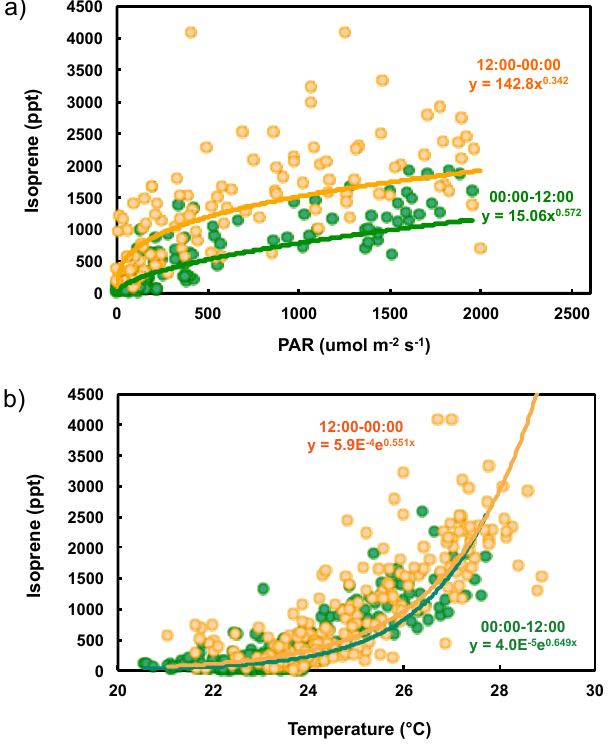
Fig. 5. Correlations between the ambient isoprene mixing ratio with, (a) PAR and (b) temperature, in the morning (between mid- night and midday – green circles) and in the afternoon (between midday and midnight – orange circles).